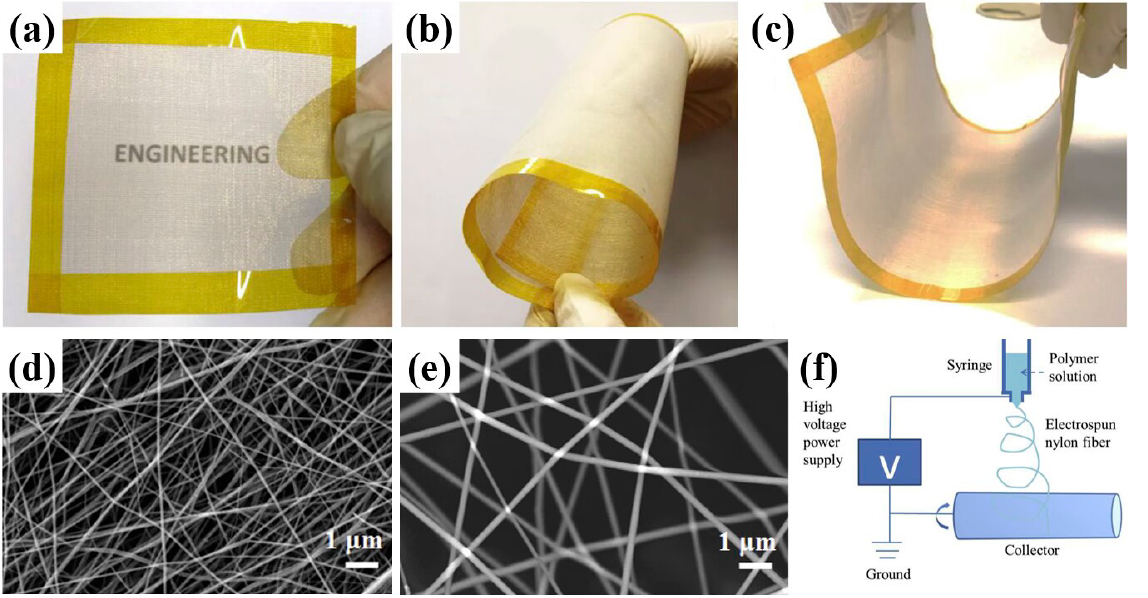
Figure 2. ( a – c ) Photographs of a fabricated nanofiber filter that was thin, transparent, and flexible [71]. ( d ) SEM image of the nanofiber filters with an electrospinning time of 3 h and a nylon concentration of 18%. ( e ) SEM image of PVA electrospun nanofibers [72] . ( f ) Schematic of the experimental setup for the electrospinning process [71] .